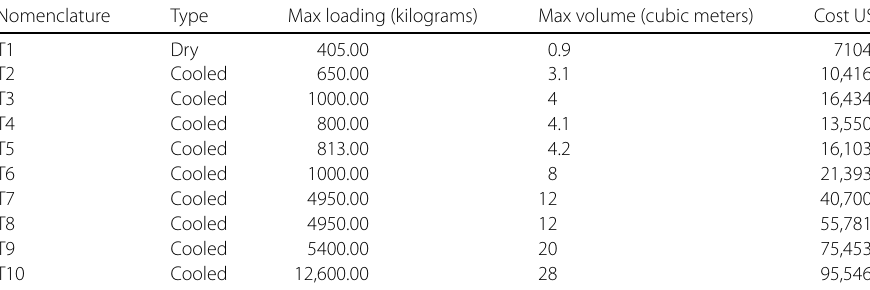
Table 1 Transport and its